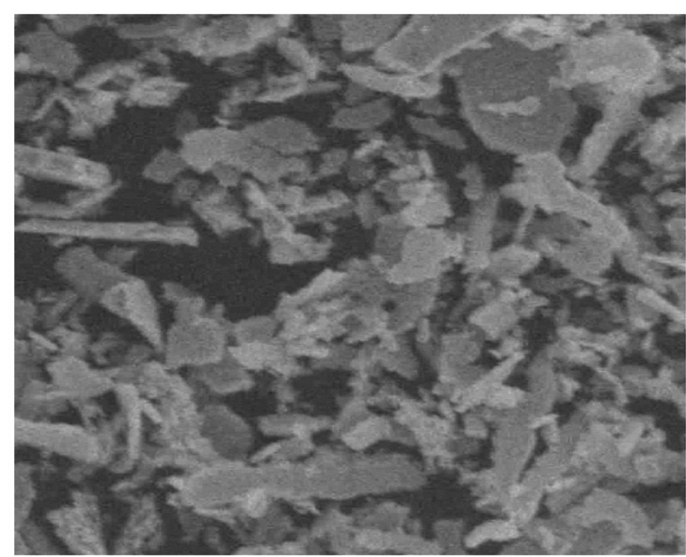
Figure 6. SEM images of Ag-NP obtained using aqueous leaf extract of Artemisia nilagirica